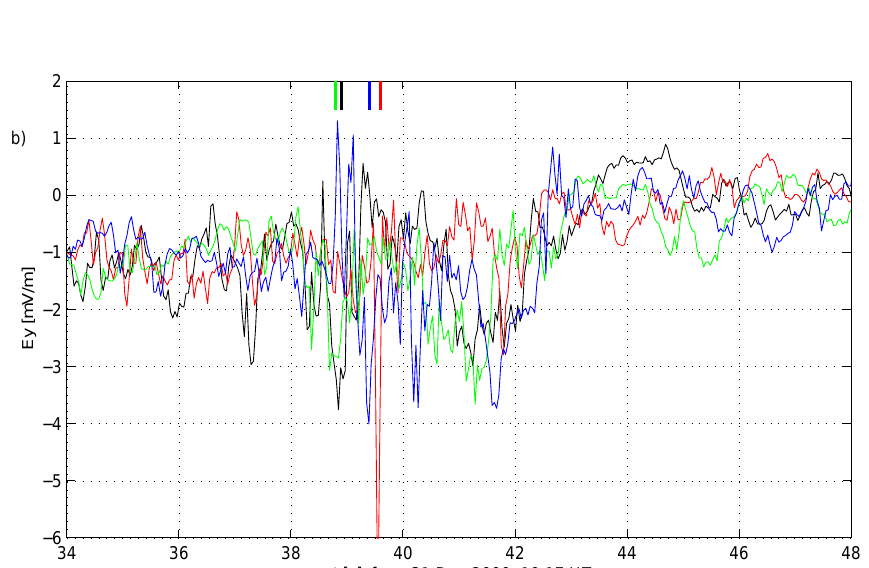
these time series have been shifted, using an estimated mag- netopause velocity of (10, 43, 27) km/s in GSE